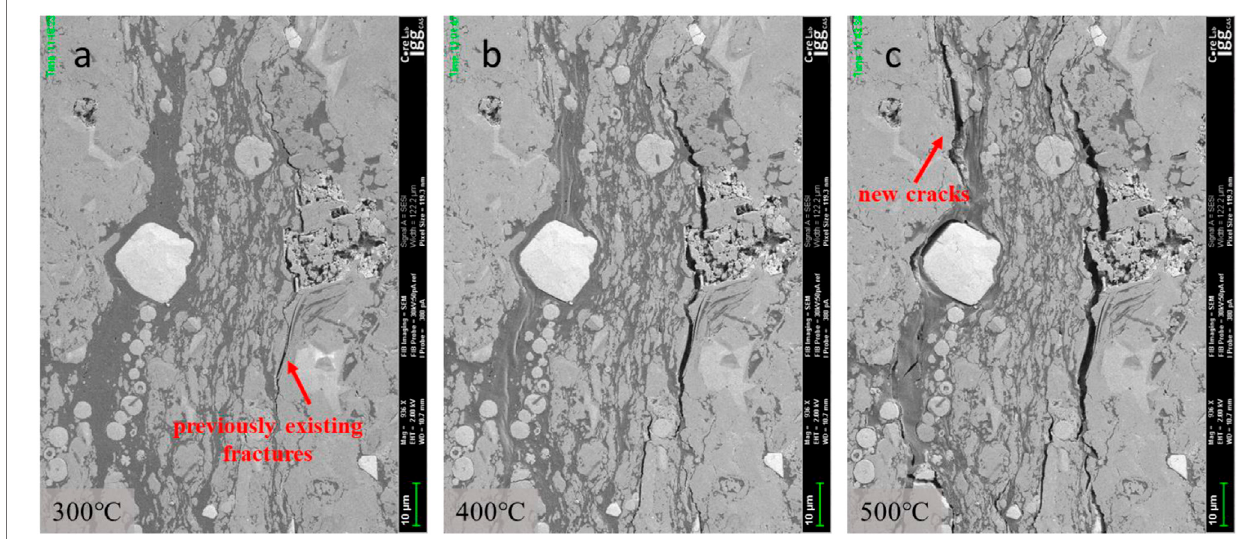
FIGURE 8 | The expansion and generation of micro-cracks in the sample with temperature change. (A) A previously existing micro-crack, (B) the expansion of a previously existing micro-crack, (C) the formation of a new micro-crack and expansion of a previously existing micro-crack.